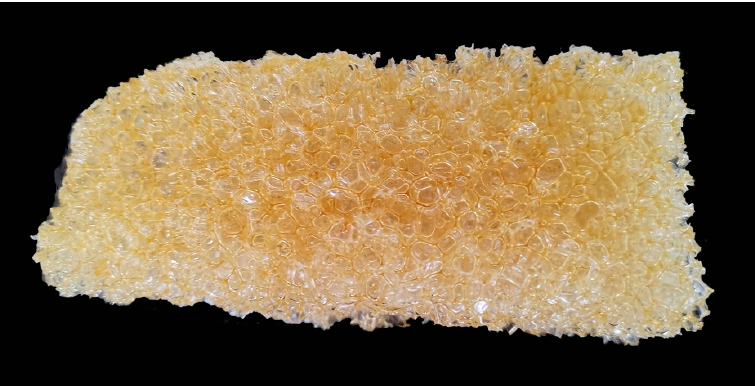
Figure 11. Cross-sectional view of polyurethane foams prepared using liquefied products at 110 min liquefaction time.